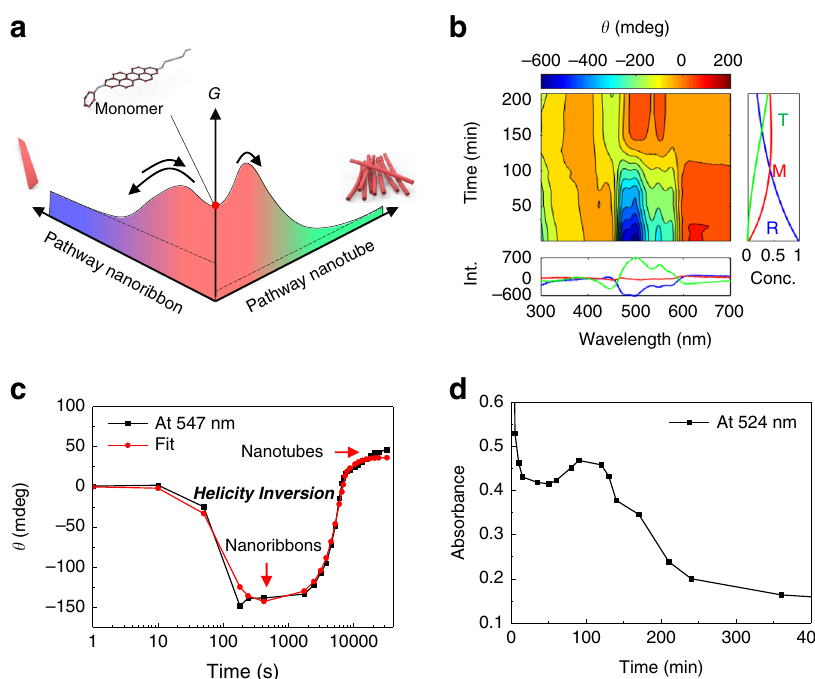
Fig. 5 Kinetics of the self-assembly process. a Reaction pro fi le for the self-assembly process. b Results of global fi tting analysis based on the kinetic model in Supplementary Fig. 24a of time-dependent CD spectra of 1-R . The CD spectra used to determine the time-dependent population evolution/decay (right panel) of nanoribbon (R, blue), monomer (M, red), and nanotube (T, green) are shown in the bottom panel. c Time dependence of CD signal intensities at 547 nm following initiation of self-assembly by cooling a heated solution from 65 to 15 °C. d Time-dependent absorbance (at 524 nm) of PDI monomers in solution after removing self-assembled supramolecules following initiation of self-assembly by cooling a heated solution from 65 °C to 15